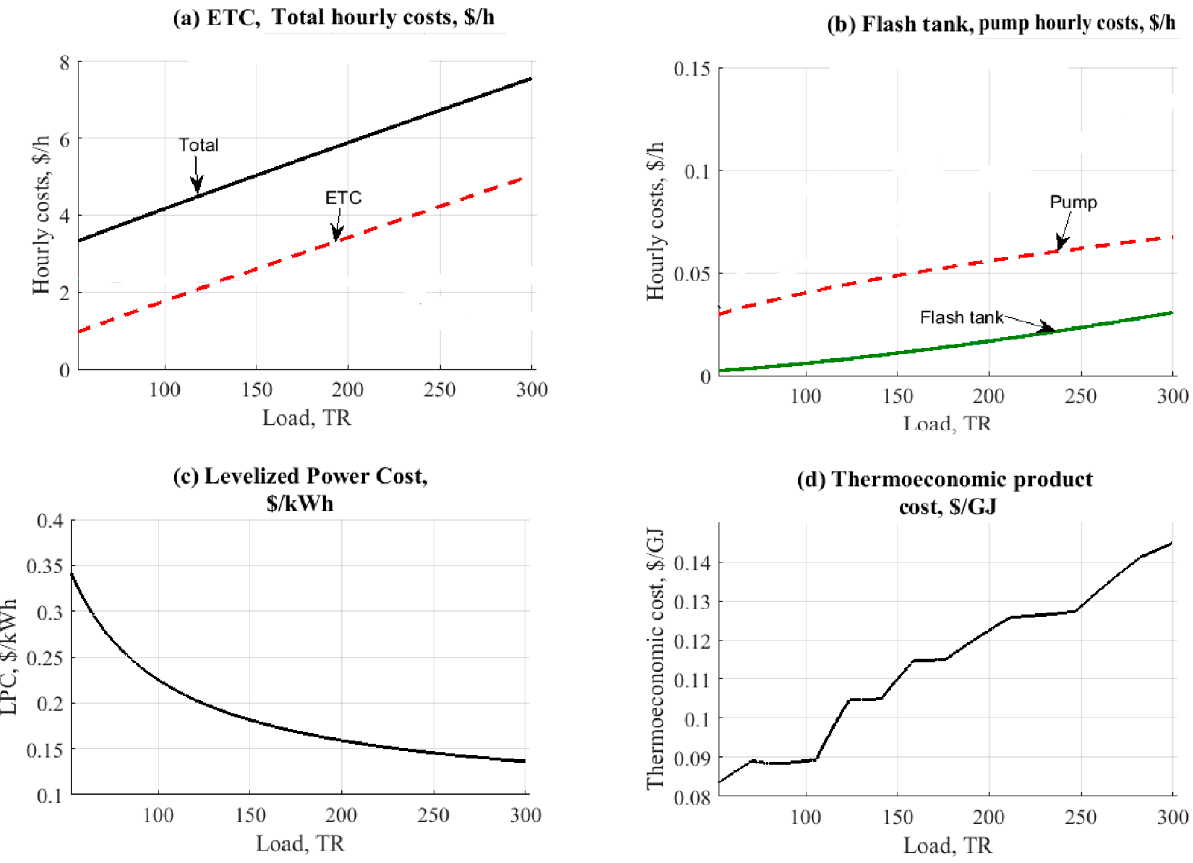
Figure 4. Data results for ETC ‐ H2O ‐ LiBr cycle vs. change in cooling load. ( a ) ETC total hourly cost. ( b ) Flash tank and pump hourly cost. ( c ) Levelized power cost. ( d ) Thermo ‐ economic product.